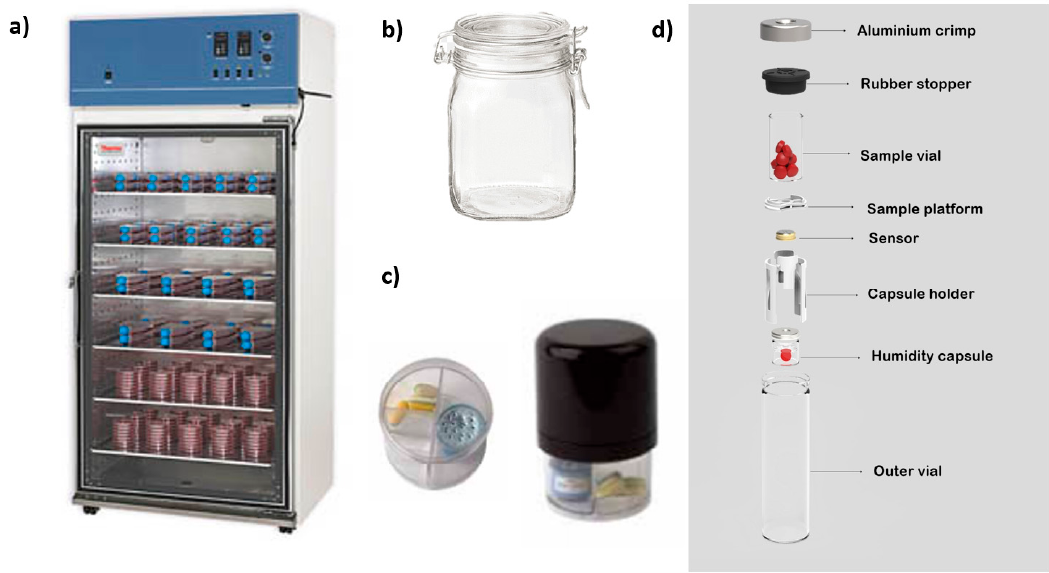
Figure 12. Types of stability chambers for ICH and APS studies. ( a ) Industrial stability chamber for ICH studies. ( b ) Simple hermetically closed jar for APSs, ( c ) Amebis Ageing System with WiFi controllers for APSs and ( d ) Cuspor Ageing System for APSs.